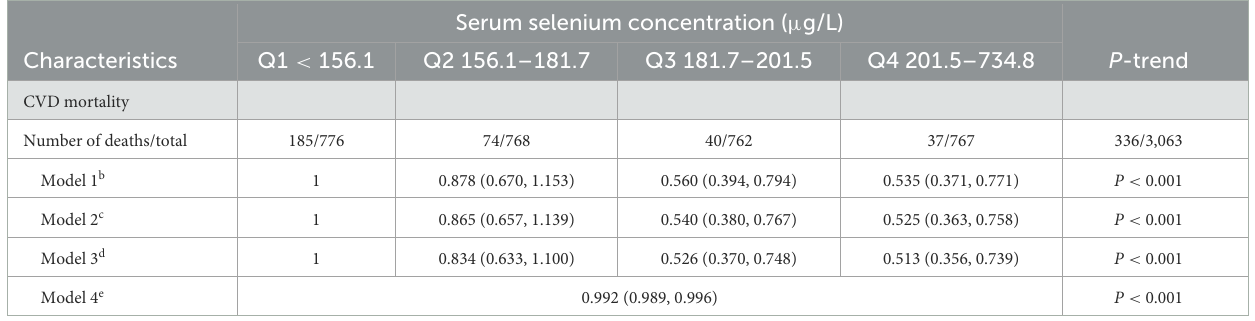
TABLE 3 CVD mortality according to quartiles of serum selenium concentrations among patients with CKD a . Serum selenium concentration ( µ g/L)